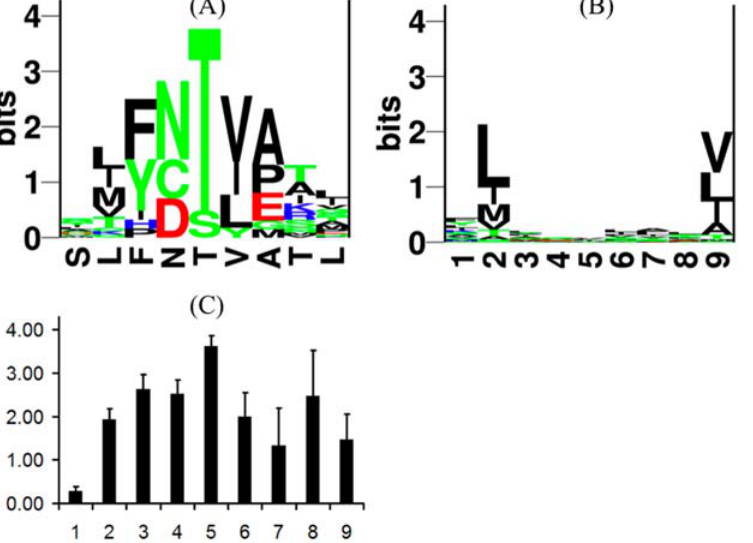
Figure 1. TCR and MHC binding motifs. (A) Logo plot [11] of recognized single variant peptides for CTL clone T4. The x-axis shows the positions in SLFNTVATL. The letters stacked on top of each position are the accepted amino acid substitutions. The y-axis gives Shannon information [14] which is a measure of how conserved a position is. Rigid positions have few but tall letters, while very degenerate positions have many but very short letters. For example, position 1 was mutated 19 times of which 18 variants preserved TCR binding, only the S1R variant compromised TCR binding while the MHC binding was preserved (see [38]). The frequency of amino acids occurring in this TCR motif can also be used to estimate the number of distinct ligands this T cell clone can recognize (see text for details). (B) Sequence motif of HLA-A2 binding peptides (277 HLA-A2 restricted peptides were extracted from the SYFPEITHI database [15]). (C) The average Shannon information at each position, for the CTL clones: G10 and T4, and PBMC.